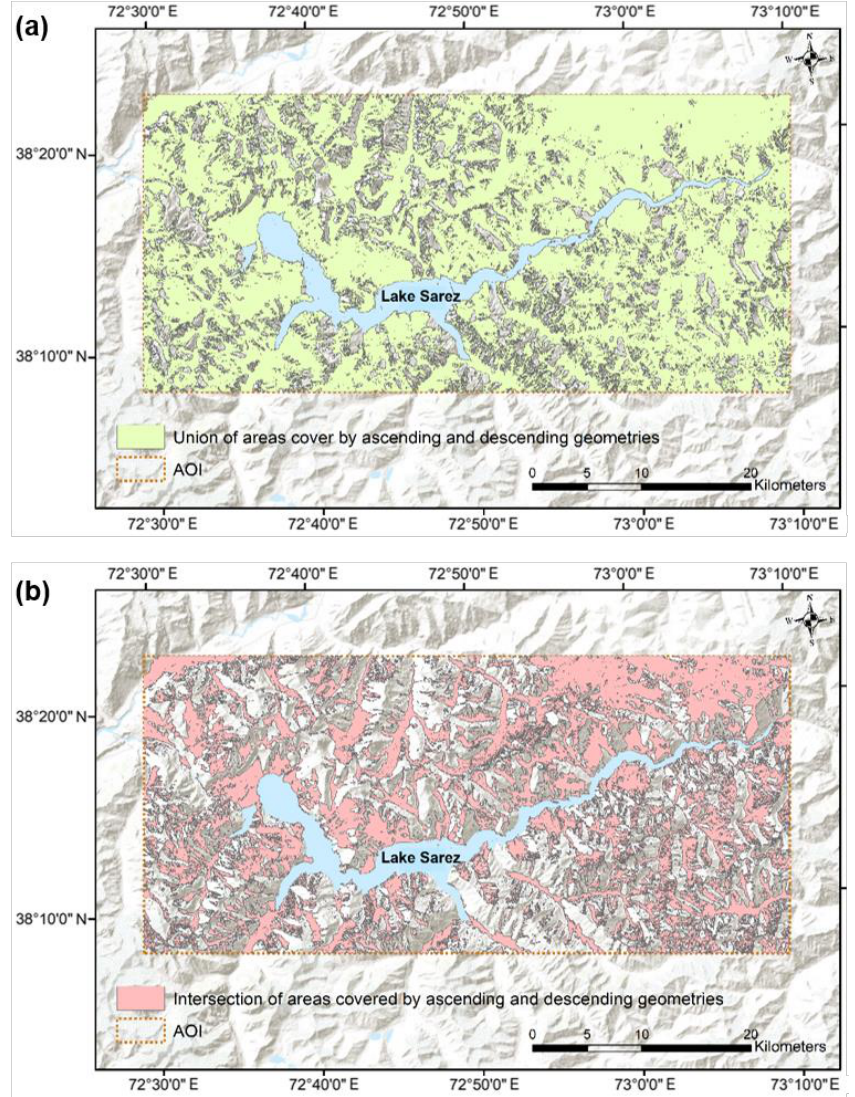
Figure 4. The coverage based on ( a ) combining the ascending and descending track geometries, and ( b ) the area common to both tracks.